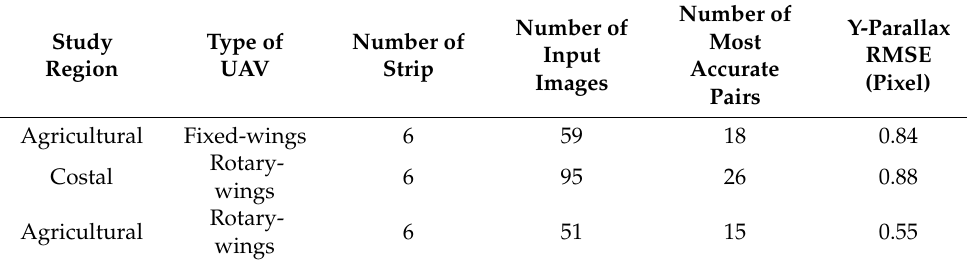
Table 6. Most accurate pair composition result for each